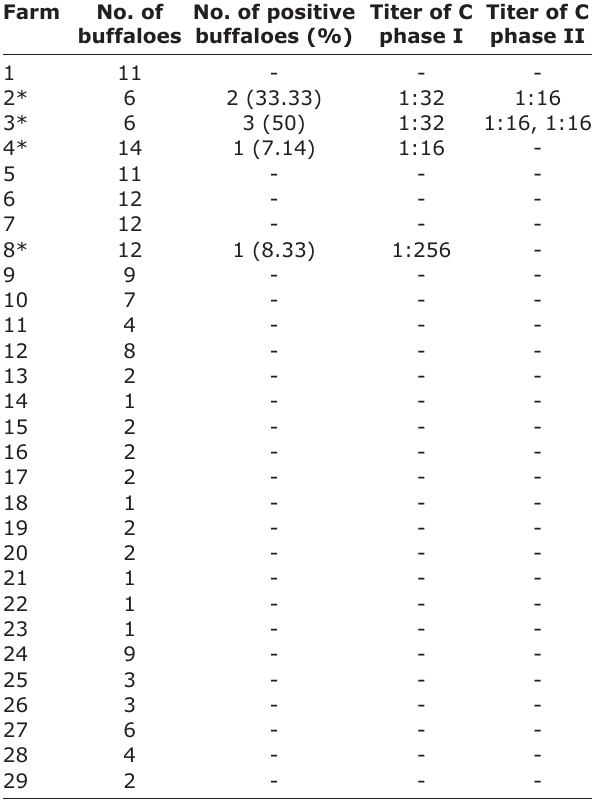
Table-2: Herd seroprevalence and titer of C Phase I and C Phase II in positive buffaloes.